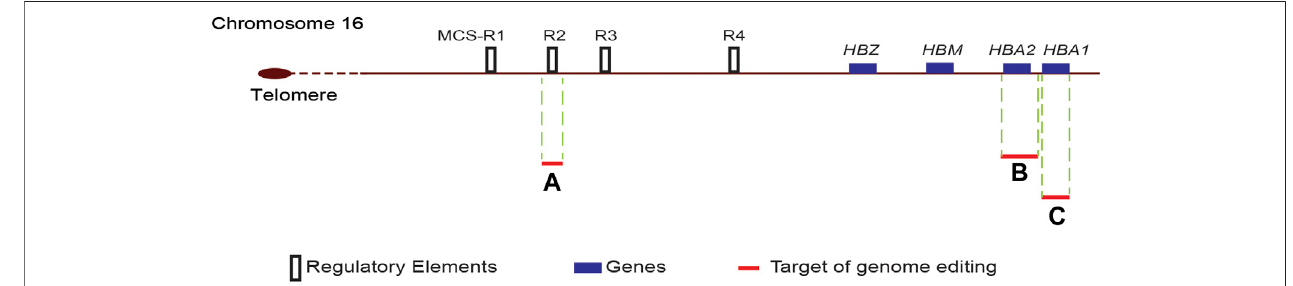
FIGURE 2 | Schematic diagram of the α -globin locus. The human α -globin locus, which consists of two α -globin genes ( HBA1 and HBA2 ), μ -globin ( HBM ) and ζ -globin( HBZ ),islocatedintheshortarmofchromosome16.Thefourdistantenhancers,multispeciesconservedsequence(MCS)R1toR4,arelocatedupstreamofthe ζ -globin gene. Target sites for genome editing are indicated by red lines, and the adjacent letter refers to the reference publication. A-(Mettananda et al., 2017b); B- (Pavani et al., 2021); C-(Cromer et al., 2021).